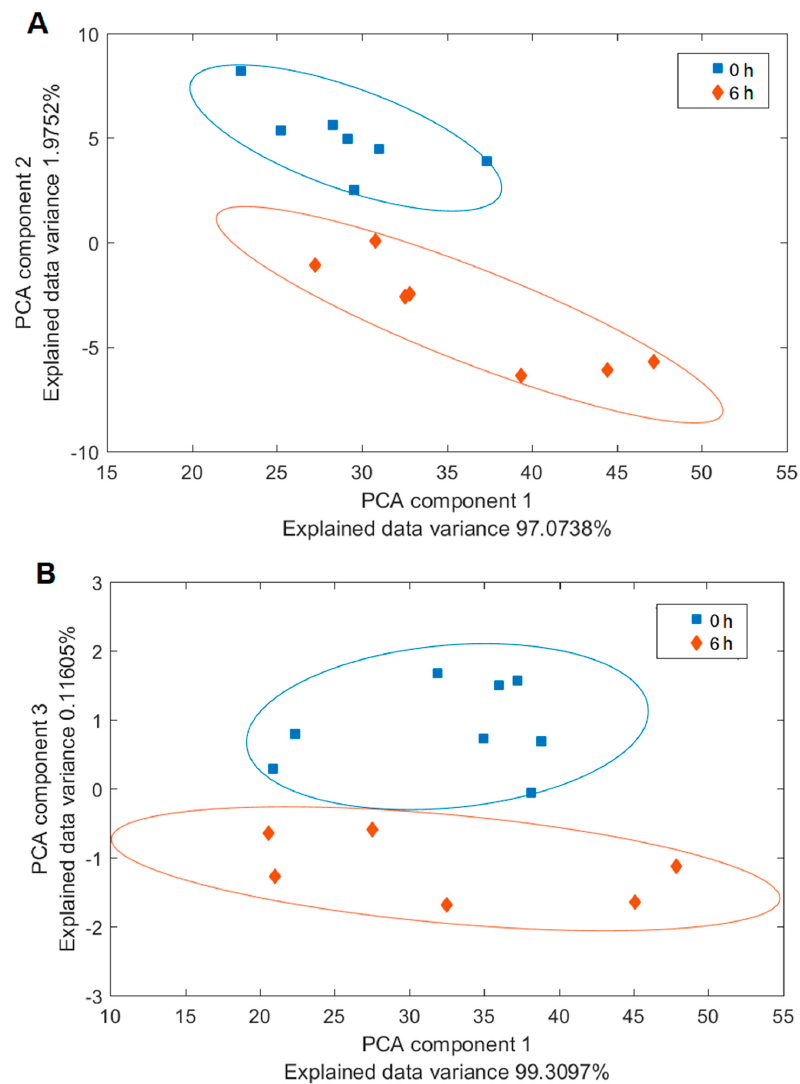
Figure 6. PCA plots for the two species ( A ) Candida parapsilosis and ( B ) Staphylococcus epidermidis . The clusters of spectra are associated with the two incubation times. Blue squares/0 h—initial cultures with no ECM; red diamonds/6 h—6 h old cultures with starting ECM formation.